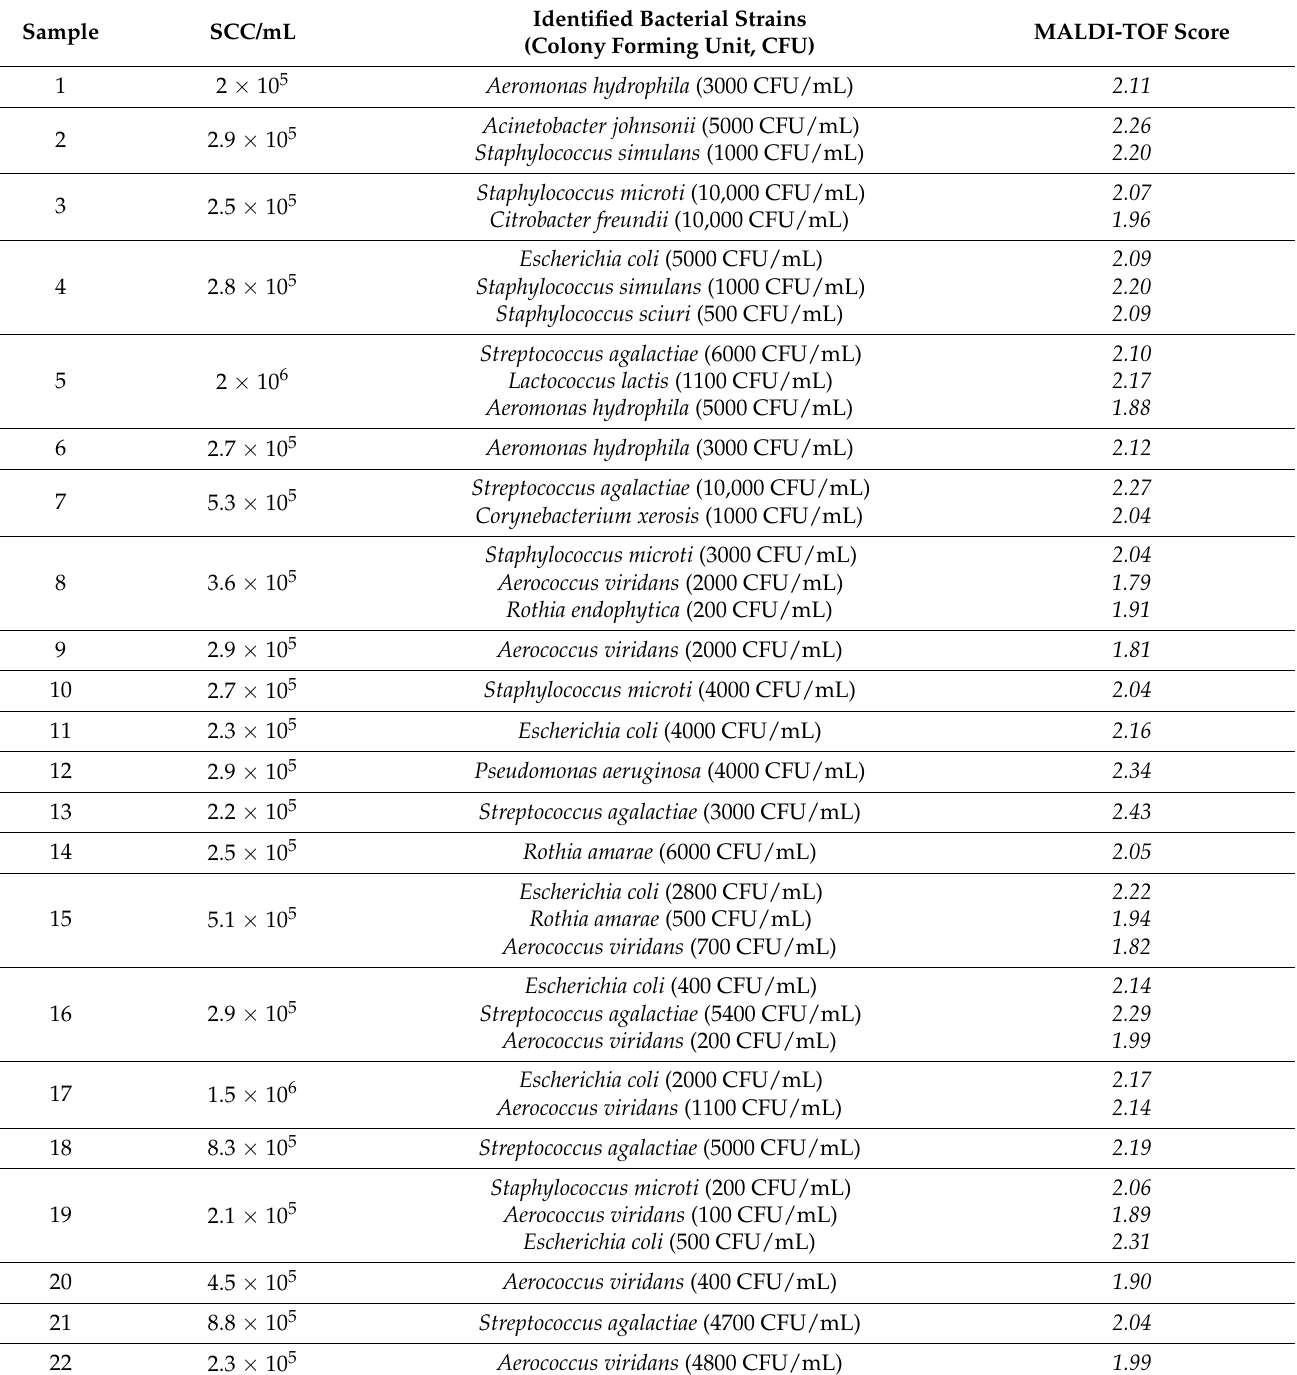
Table 5. Bacterial species and MALDI-TOF scores in 22 buffalo milk samples showing high somatic cells counts (SCC) compatible with the definition of subclinical mastitis